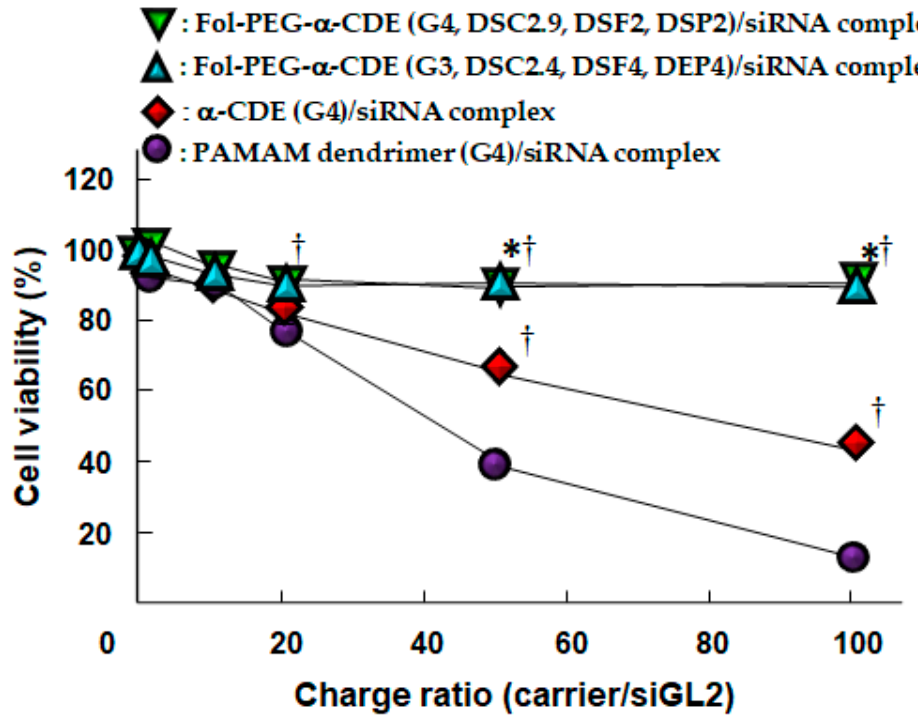
Figure 8. Cytotoxicity of various carrier/siRNA complex in KB cells (FR (+)). The cells were incubated with carrier/siRNA complexes for 24 h. Cell viability was assayed by WST-1 method. The concentration of siGL2 was 100 nM. Culture medium was supplemented with 10% FBS. Each point represents the mean ± S.E. of 3–4 experiments. * p < 0.05, compared with α -CDE (G4). † p < 0.05, compared with dendrimer (G4)/siRNA complex.